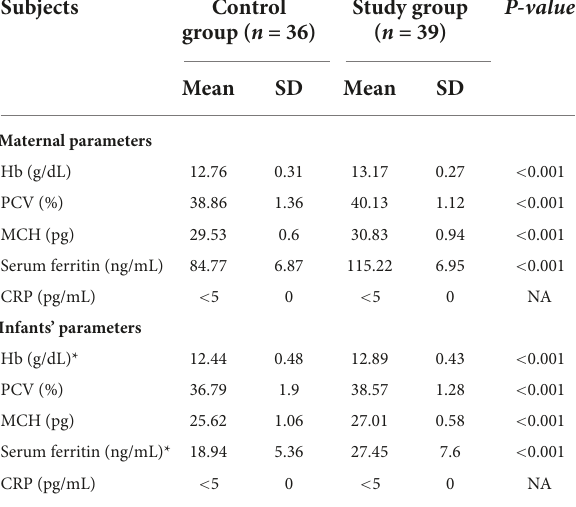
TABLE 3 Hematological parameters of mothers and infants at 6 months.